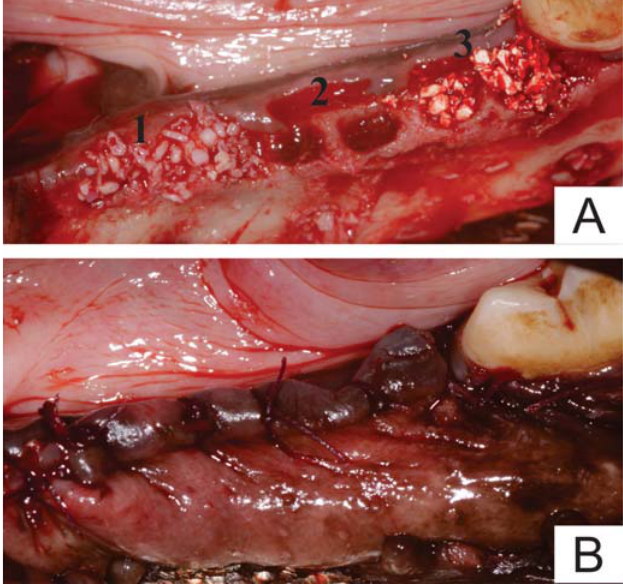
Fig. 1. Left side of beagle mandible: A) 1- First alveolus – Bio-gen® + PRP; 2- Second alveolus – clot + PRP; 3- Third alveolus – Genox® + PRP; B) Suture with single stitch recovering alveolar